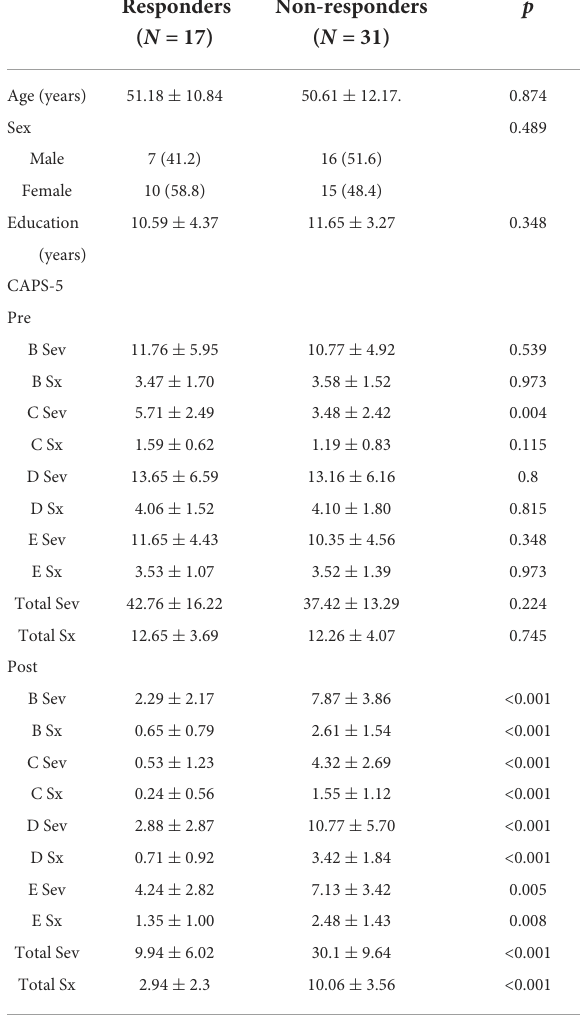
TABLE 1 Demographic and clinical characteristics of responders and